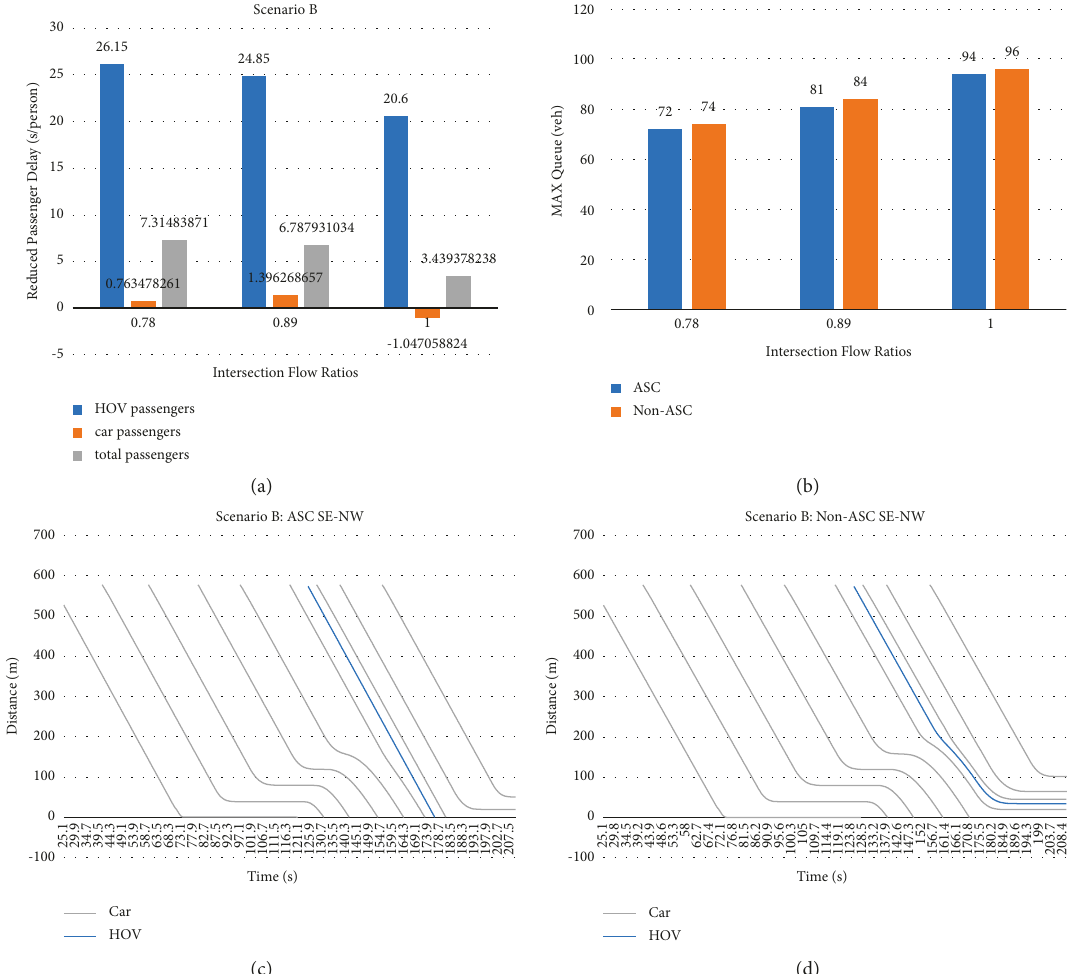
Figure 8: ASC optimization results in scenario B (a) Reduced passenger delays (b) Max queue (c) Vehicle trajectories under ASC (d) Vehicle trajectories under fixed